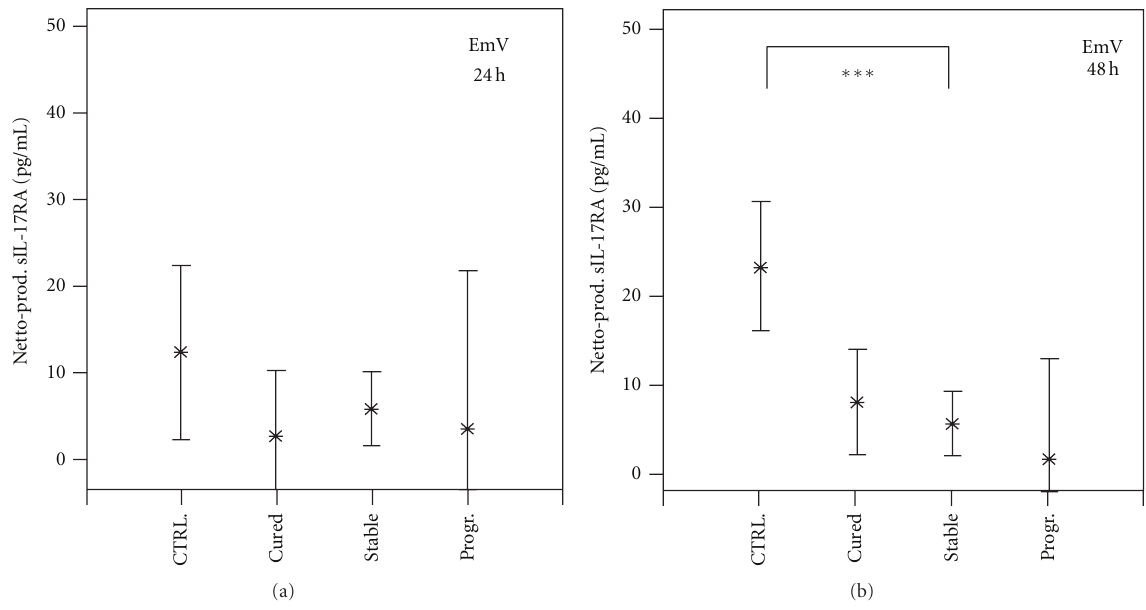
Figure 3: Echinococcus multilocularis antigen induced cellular production of soluble interleukin-17 receptor A (sIL-17RA) by peripheral blood mononuclear cells (PBMCs) from Alveolar Echinococcosis (AE) patients and infection-free controls (CTRL). Patients were grouped according to their state of infection, that is, cured, stable, or progressive (Prog.) Alveolar Echinococcosis. PBMCs from patients and controls were stimulated with E. multilocularis vesicle extract (EmV) for 24 (part a) and 48 hours (part b) or left without stimulation. Cytokine concentrations in cell culture supernatant were quantified by specific ELISA. The EmAg-induced cytokine production (Netto Prod.) was calculated by subtracting the cytokine production in not stimulated PBMC cultures from EmV-stimulated cytokine production. The cytokine production is shown as mean values in pg/mL with the 95% upper and lower confidence interval. The level of significance was adjusted by the Bonferroni-Holm method. The significant di ff erences between groups are indicated ( ∗ P < 0 . 05, ∗∗ P < 0 . 01, ∗∗∗ P < 0 .